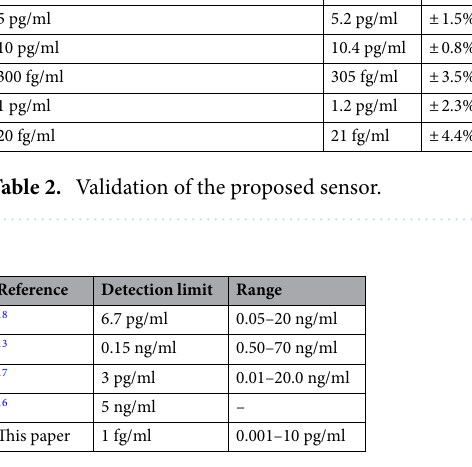
Table 3. A comparison of the proposed PoC system with existing